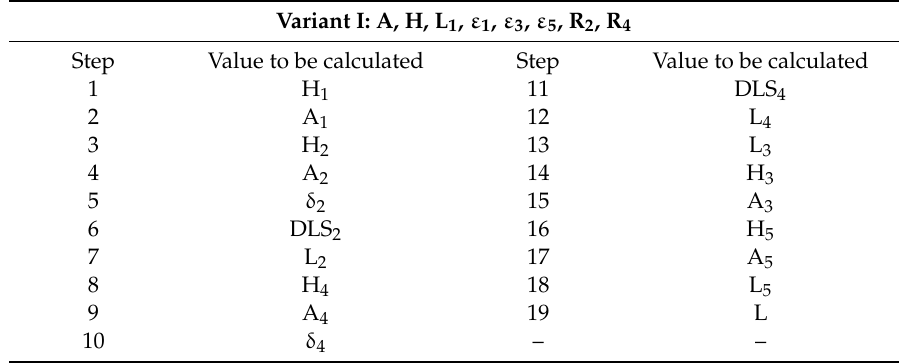
Table 2. The order of calculating the characteristic values for a trajectory consisting of 5 sections with the given input parameters: A, H, L 1 , ε 1 , ε 3 , R 2 , R 4